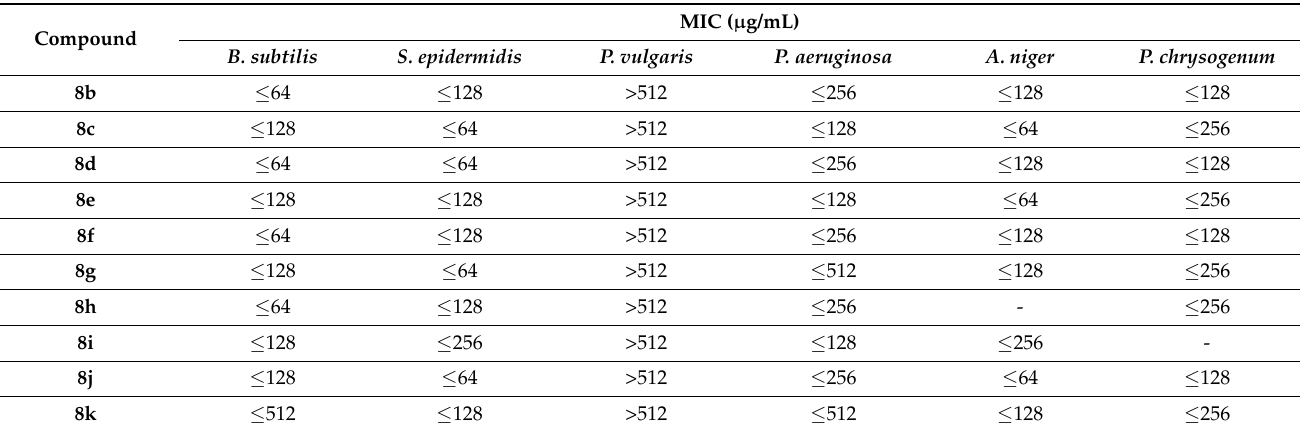
Table 10. MIC values of ( µ g/mL) of the synthesized pregnane oxime derivatives. Adapted with permission from Ref [88], 2023, Ana S.